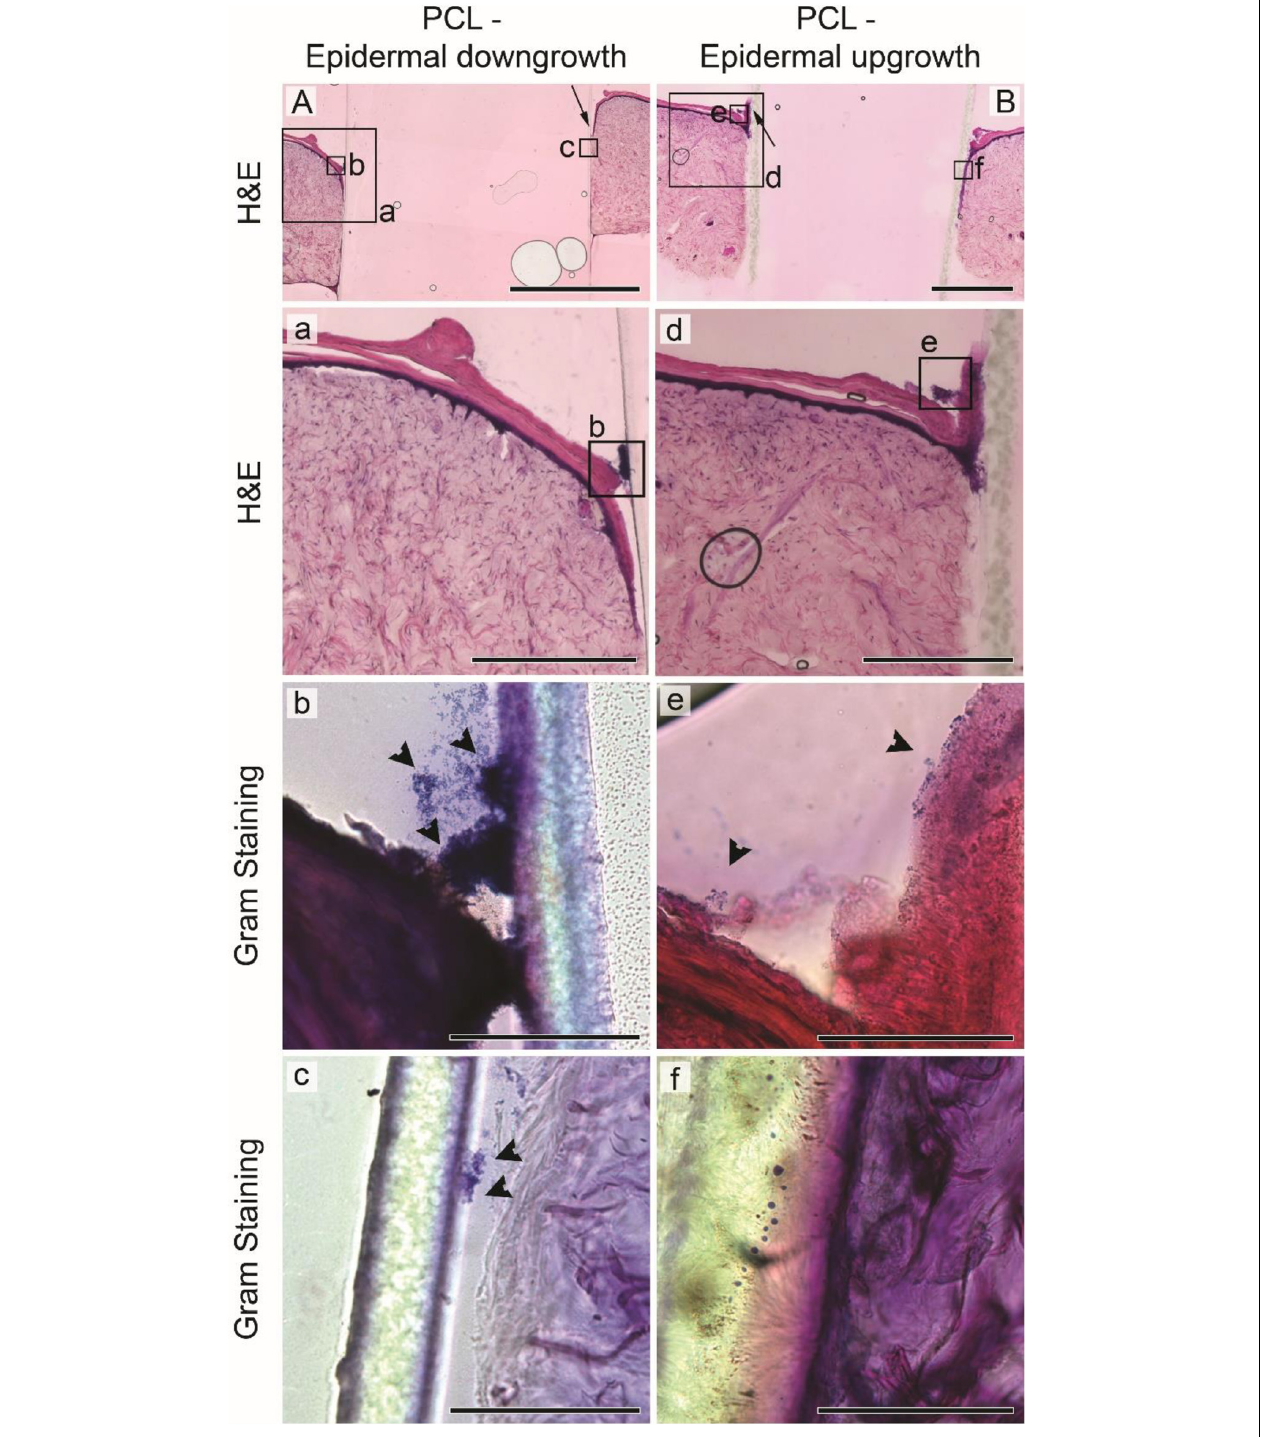
FIGURE 4 | Staphylococcus aureus infection of HSEs implanted with smooth drivelines. Histological analysis by H&E staining of cross sections of HSEs implanted with a PCL mock driveline, exhibiting (A) epidermal downgrowth or (B) epidermal upgrowth, as indicated by the black arrows (scale bars: 2 mm). Panels (a) and (d) show digital magnifications of marked regions from H&E images shown in (A,B) , scale bars: 500 µ m. Irrespective of epidermal growth pattern, Gram staining revealed bacterial colonization at the driveline entry point [panels (b) and (e)], denoted by black arrowheads, but limited or no presence of bacteria further along the skin – driveline interface [panels (c) and (f), scale bars 100 µ m]. All images are from sections from the same samples with specific regions marked by black boxes in (A,B)